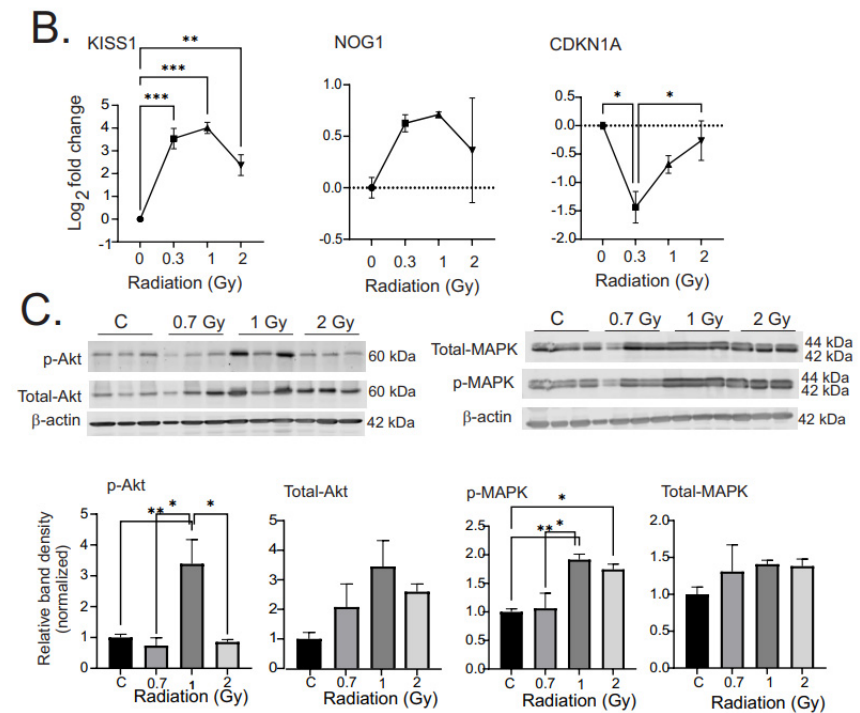
Figure 5. Heatmaps of gene expression changes for pathways in regulation of proliferation and cell division. ( A ). RNAseq was used to identify gene expression changes in primary human MSCs following 1 or 2 Gy (0.66 cGy/h) 60 Co irradiation. Control cells were cultured under identical conditions for 1 or 2 weeks. GO analysis was performed using DAVID and heatmaps were generated using genes with q < 0.05. Rows are centered and unit variance is applied to rows. ( B ). qPCR gene regulation using log base 2 scale fold change of genes supporting heatmaps of pathways. Data show averages ± SEM N = 3 biological replicates with two technical repeats; * indicates p < 0.05, ** indicates p < 0.01, *** indicates p < 0.001, respectively, compared with sham-irradiated control cells. ( C ). Western blot data showing regulation of AKT and MAPK (phosphorylated and total). Western blots were performed on N = 3 biological repeats. Bar graphs show average band densities normalized to β - actin. Graphs show means ± SEM; * indicates p < 0.05 and ** indicates p < 0.01, respectively, compared with sham-irradiated control cells.